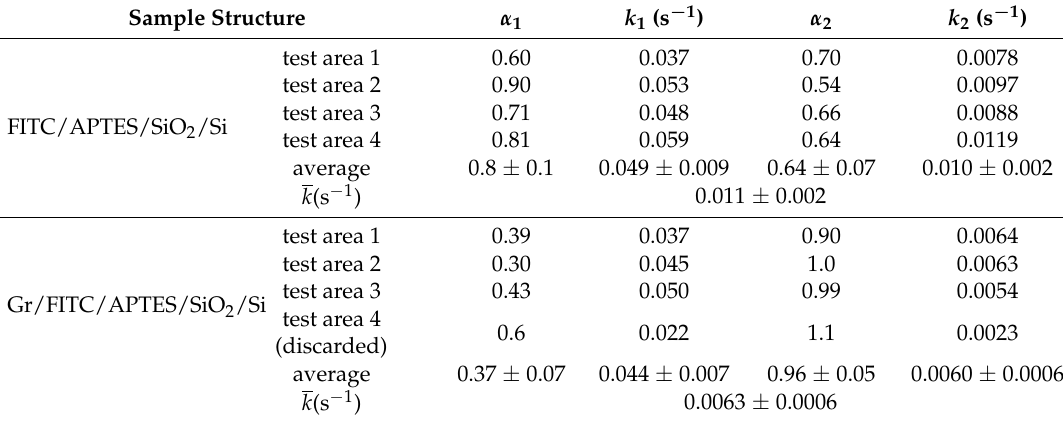
Table 1. The photo-bleaching rate and pre-exponential factor of the biexponential decay obtained by fitting the photo-bleaching curve of FITC dye in the absence (black) and presence of graphene (red) in Figure 4. Note that experiment #4 of Gr/FITC/APTES/SiO 2 /Si sample showed extremely slow photo-bleaching kinetics (slower than in the absence of graphene) and was not included in our analysis. It is possible that this data was taken from an area with aggregation of dyes or